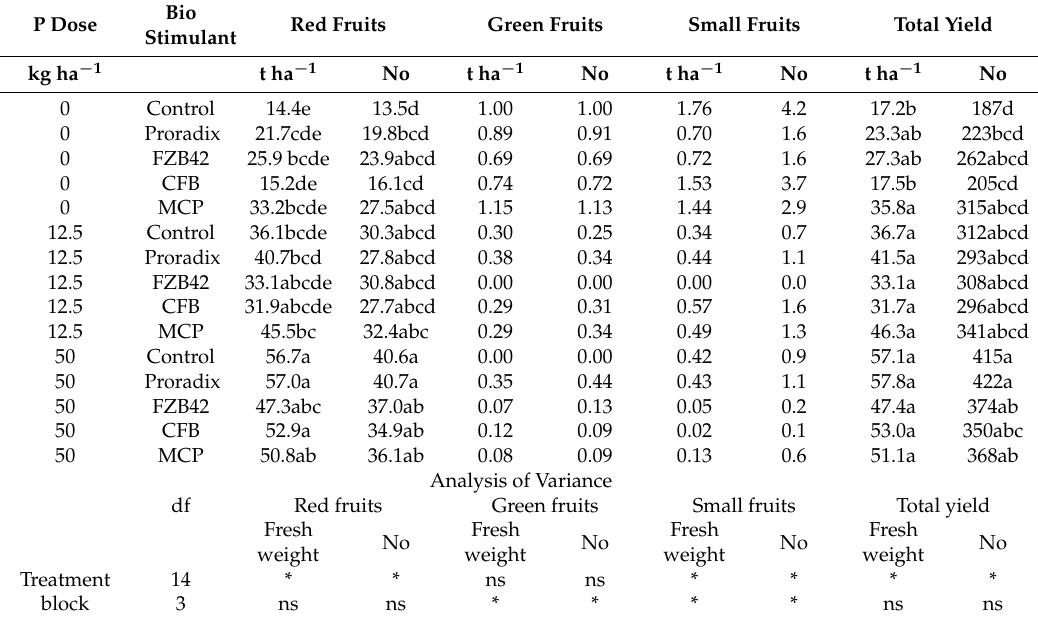
Table 2. Effect of banded P fertilization with DCD-stabilized ammonium sulfate and BS on total yield, fruit number per plant (No), and fruit quality distribution of drip-irrigated tomato between 4 and 5 months after sowing, Ramat Negev, Israel. Means represent four replicates. Statistical evaluation performed by two-way ANOVA. Significant treatment differences (Tukey test, p ≤ 0.05 and Tukey–Kramer HD test) are indicated by different characters, n.s.: not significant, * = significant after Tukey–Kramer HD